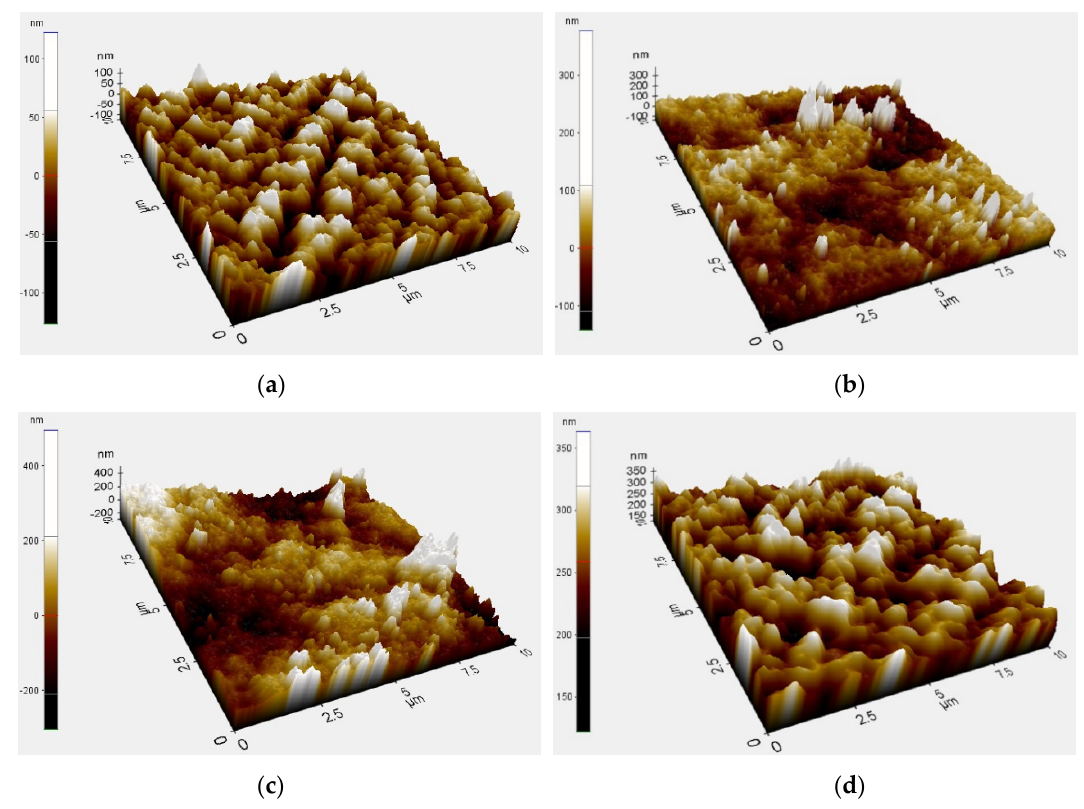
Figure 4. Atomic force microscopy (AFM) three-dimensional surface micrographs of ( a ) neat PVDF membrane and PVDF membrane immersed in a coagulation bath with different types of TiO 2 at a concentration of 0.01 g/L, ( b ) PC-20, ( c ) P25, ( d ) X500. Table 4. Surface roughness of PVDF/TiO 2 MMMs and neat PVDF membrane.